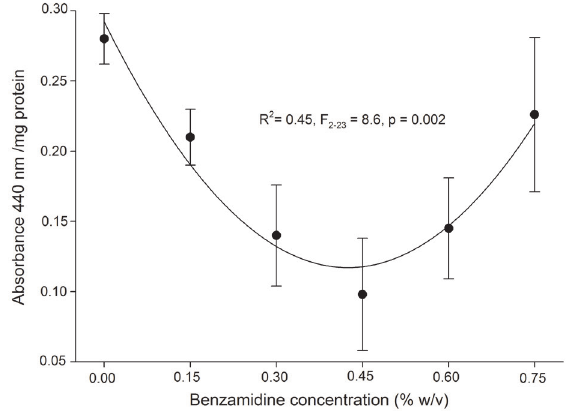
Figure 1 - Indirect determination of trypsin inhibitors in soybean leaves sprayed with benzamidine at different concentrations in presence of larvae of Anticarsia gemmatalis . Point and line indicate mean ± SE of four plants.